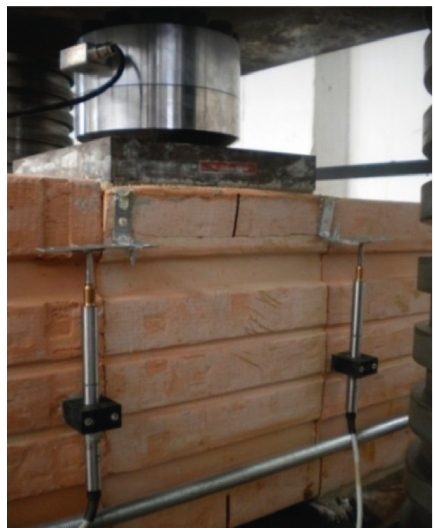
Figure 12: Second specimen failure under the maximum load.